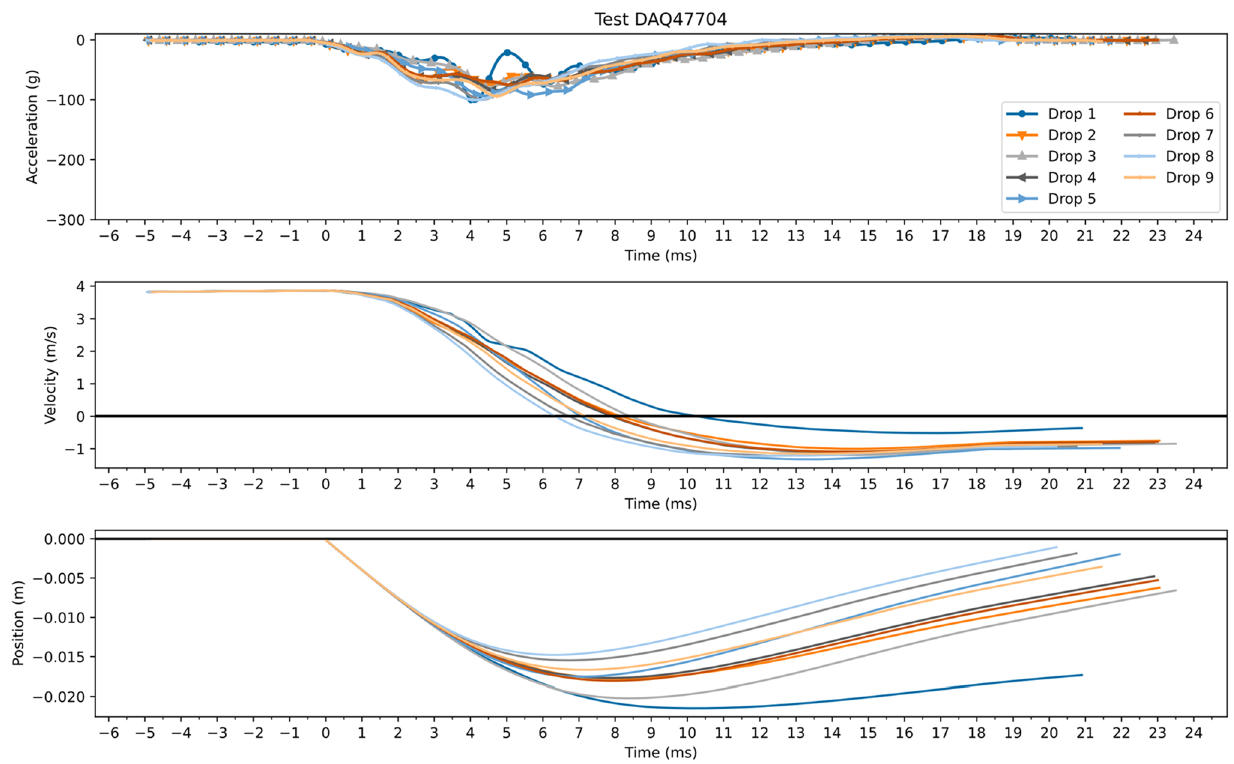
Fig. 13 Measured acceleration and derived velocity and position for P2 and 4–4-4 wrapping pattern